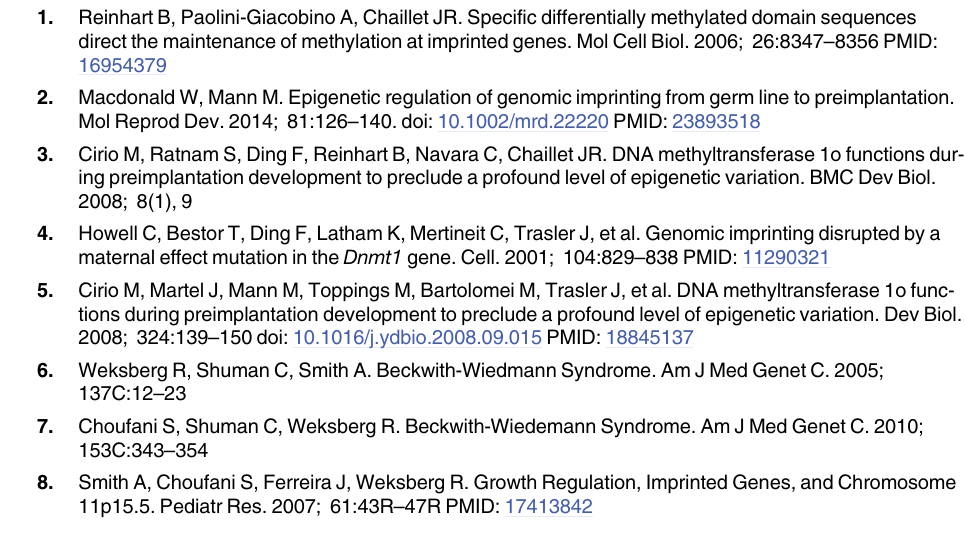
S1 Table. Bisulfite PCR Amplicons and Primer Sequence and Coordinates. Forward and Reverse sequence tags attached to each primer pair for EpiTYPER methylation analysis. Geno- mic coordinates of imprinted gDMDs from the most recent mouse genome build (GRCm38). Imprinted gDMD amplicons in bold were those used to calculate average imprinted gDMD methylation fraction in Fig 1A. S2 Table. Stepwise forward linear regression analysis of associations between imprinted gDMD methylation and TGC accumulation in E12.5 DNMT1o-deficient placentas. N = 24, df = 21, model P-value = 1.54x10 -5 . S3 Table. Bivariate regression analysis of E15.5 DNMT1o-deficient placental methylation and phenotypes. Only significant (P < 0.05) associations are shown. Regression coefficient is either the logit (log odds ratio) for logistic regression for fetal viability, or the linear regression coefficient ( β ) for all other variables. S4 Table. Linear regression analysis reveals association between imprinted gDMD methyla- tion and placental and fetal weights at E17.5. Only associations with strong (P < 0.075) are shown. The linear regression coefficient ( β ) is reported for both phenotypic